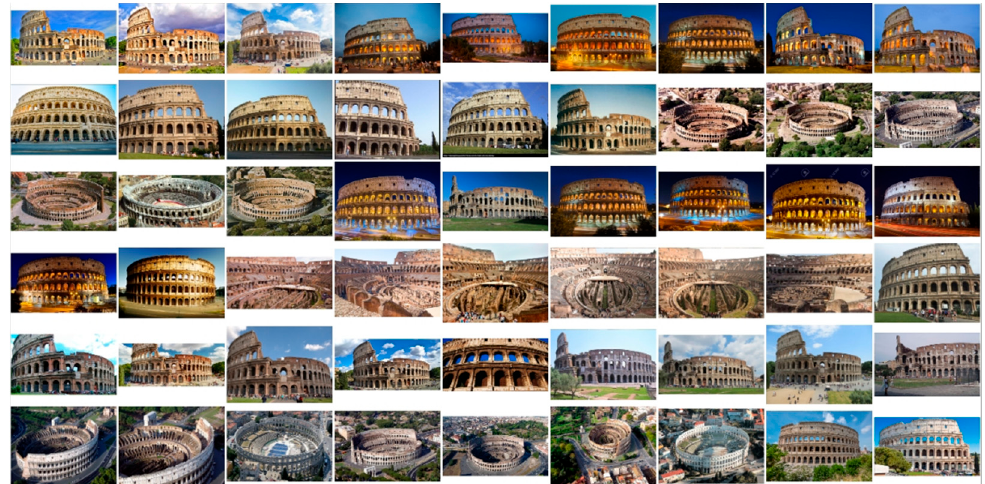
Figure 6. Samples from Colosseum dataset.